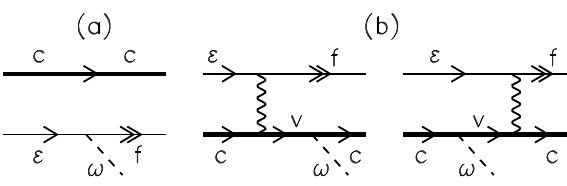
Figure 5. Feynman diagrams for amplitudes of the RR ( a ) and PRR ( b ) processes. Here, thin lines describe the transition of the incident electron with the energy ε into the bound f -state. Thick lines “c” relate to the target electrons and “v” to their virtual states. Dashed lines denote the emitted photon with the energy ω . The Coulomb interaction is indicated with wave